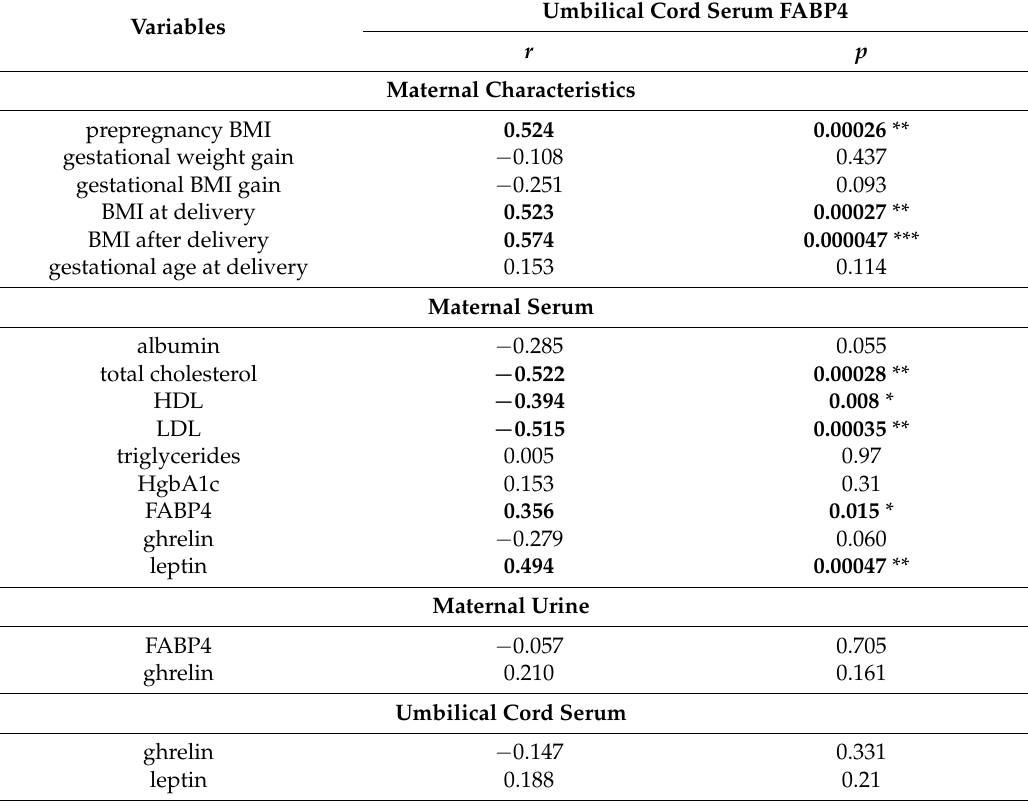
Figure 1. FABP4 levels in the umbilical cord serum, maternal serum, and urine in the control and GDM groups. ** p < 0.001; *** p < 0.0001; NS—not statistically significant. No significant differences in the FABP4 levels were observed in the maternal serum ( p = 0.41), urine ( p = 0.06), and umbilical cord serum ( p = 0.11) between the GDM subjects undergoing intensive Table 2. Correlation coefficient between the umbilical cord serum FABP4 levels and the clinical insulin therapy and those who were treated with a daily single insulin injection. parameters in both study